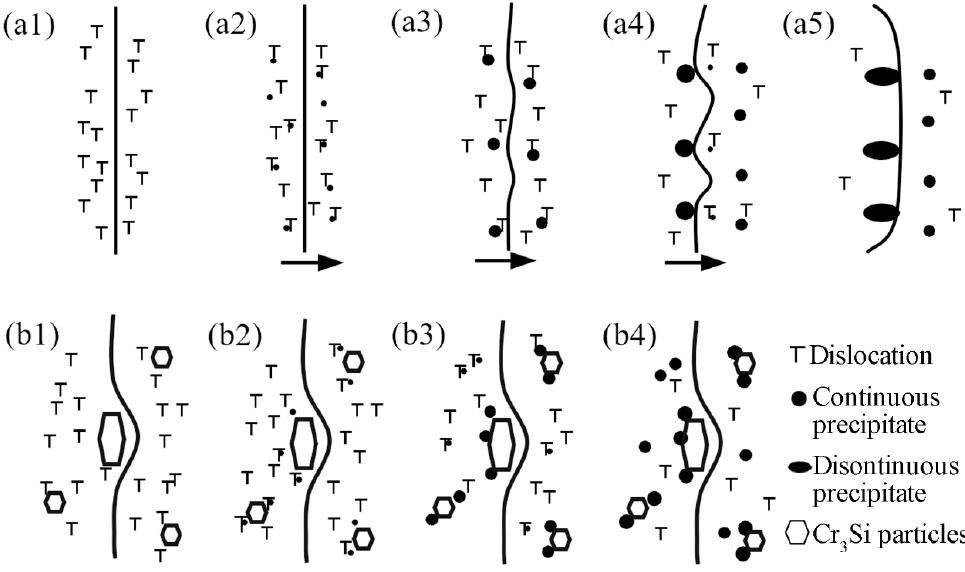
Figure 10. Schematic on the precipitation process of cryo-rolled CuNiSi alloys ( a1 – a5 ) and CuNiSiCr alloys ( b1 – b4 ).